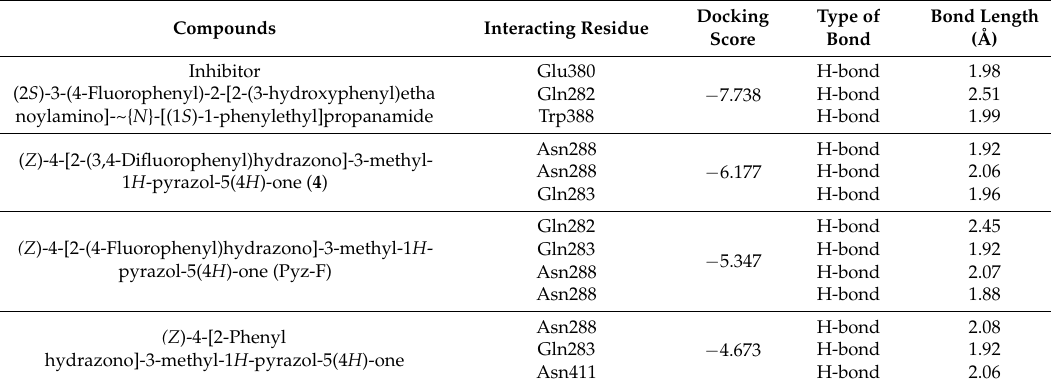
Figure 2. Interaction of compound 4 with hGLUT1. Table 4. Molecular docking results compound 4 and its analogues with